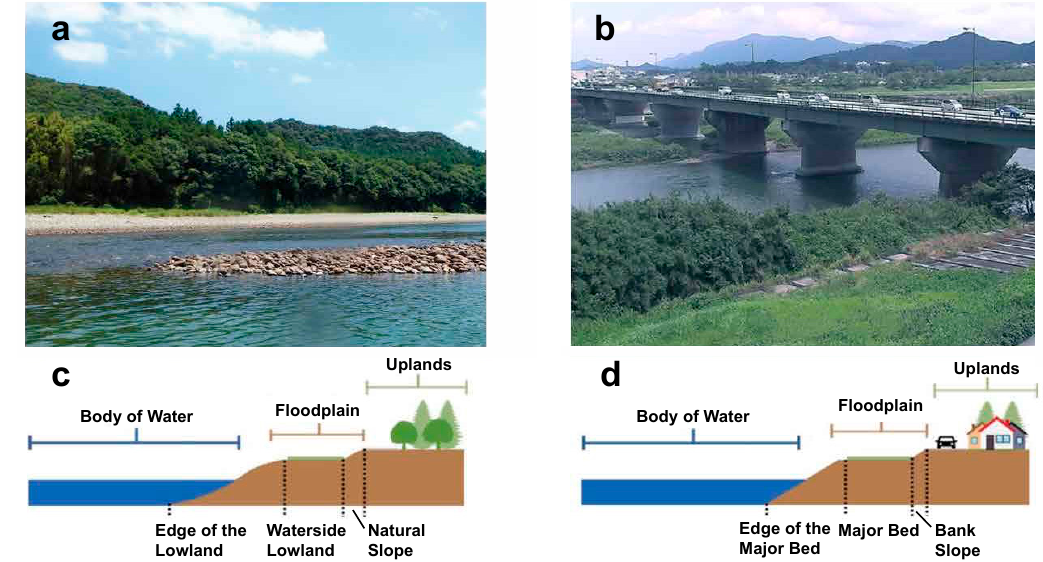
Figure 2. Examples of the sampling area. ( a , b ) example images of waterside lowland and major bed; ( c , d ) example section structure of waterside lowland and major bed.